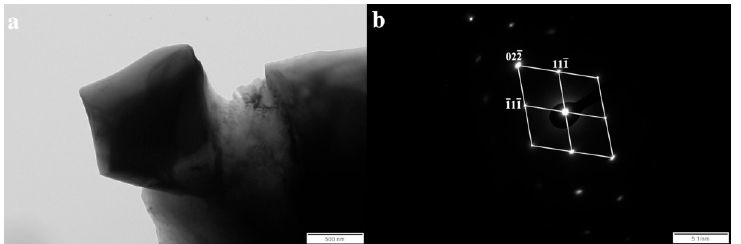
Figure 6. ( a ) Bright field image of the NbC carbide in layer I. ( b ) Selected area diffraction pattern (SAED) of the primary NbC [011] carbide shown in Figure 6a, along with the solution. Transmission electron microscope, 150 kV.